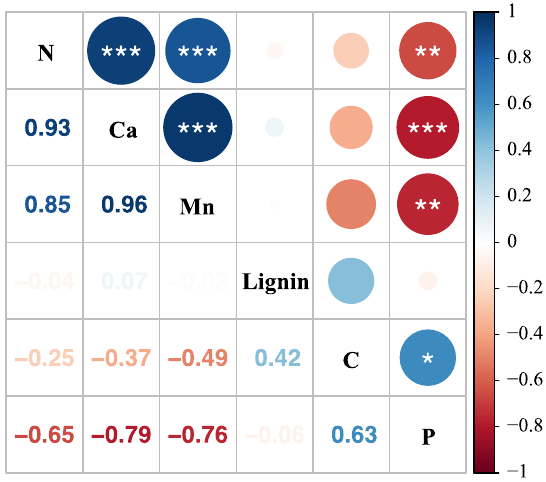
Figure 2. Pearson’s correlation coefficient (r) between the initial chemical components of Qinghai spruce leaf litter (mg·g − 1 DM) at different altitudes. Notes: Values are from bulk litter of each site. n = 15. *, p < 0.05; **, p < 0.01; ***, p < 0.001.